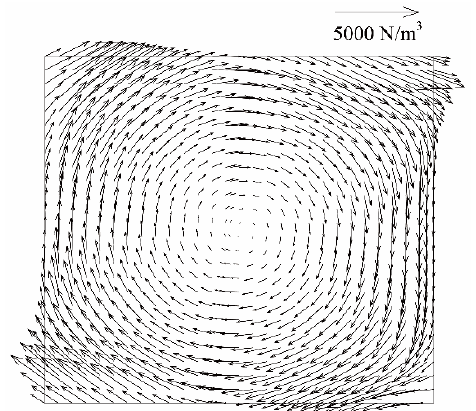
Figure 5. Electromagnetic force distribution at EMS central cross-section in curved bloom continuous caster.